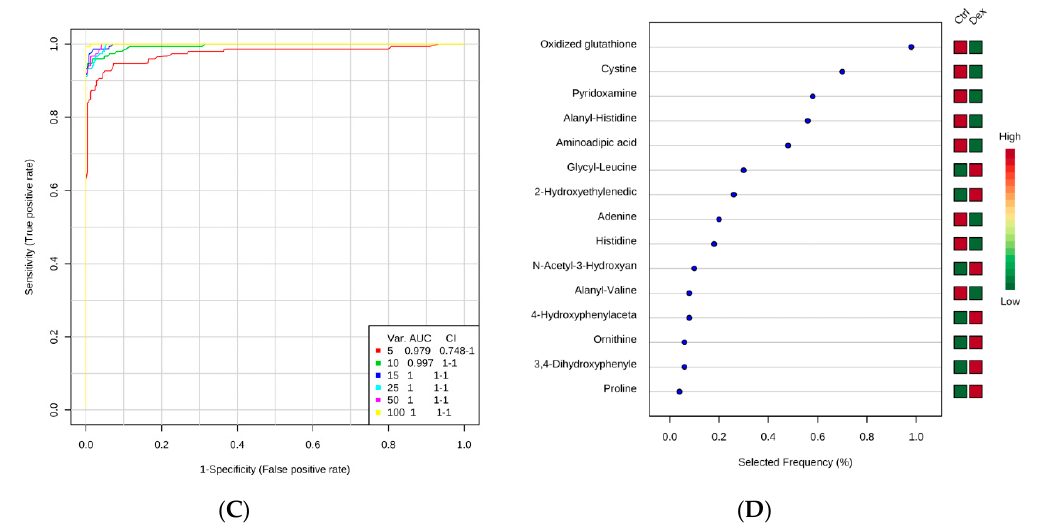
Figure 1. Rat brain tissue submetabolomic profile after prolonged treatment with dexamethasone (Dex). ( A ) Orthogonal partial least squares ‐ discriminant analysis (OPLS ‐ DA) score plot ( Q 2 = 0.892, R 2 = 0.996) shows a clear separation between the healthy brain tissue (Ctrl, n = 5) and Dex ‐ treated groups ( n = 4). Tissue samples were run on LC ‐ MS in duplicate. ( B ) Volcano plot shows the statistically significant altered metabolites (false discovery rate (FDR) ‐ corrected p ‐ value < 0.05, and fold change (FC) > 1.2 or < 0.83). The levels of 235 metabolites were down ‐ regulated (blue) and 257 were up ‐ regulated (red) in the Dex ‐ treated rats. ( C ) The ROC curve was generated by the OPLS ‐ DA model, with AUC values calculated from the combination of 5, 10, 15, 25, 50, and 100 metabolites. ( D ) Frequency plot shows 15 positively identified metabolites.